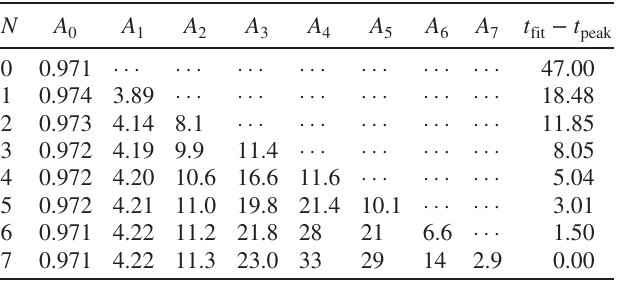
TABLE I. Best-fit estimates of the amplitudes A n of the fundamental mode and overtones in the ringdown of NR simulation SXS:BBH:0305, with t 0 ¼ t computed for various values of N , the total number of overtones included in the fit. Also shown is the time t performed for each N , stated with respect to t always the amplitudes at t ¼ t 0 ¼ t performed at a later time. The amplitude values are truncated such that the last significant figure agrees with the two highest resolutions for the NR simulation.